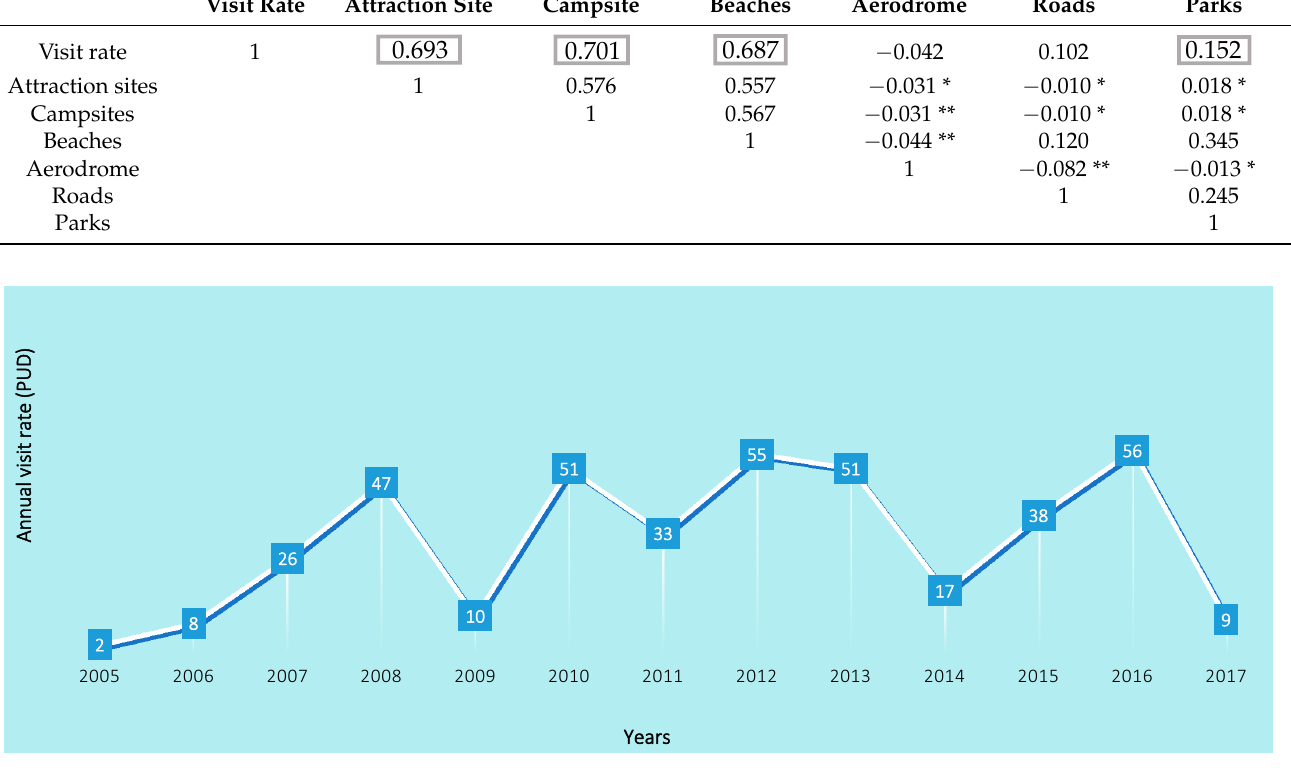
Figure 4. Annual visit rate evolution in the period 2005–2017.